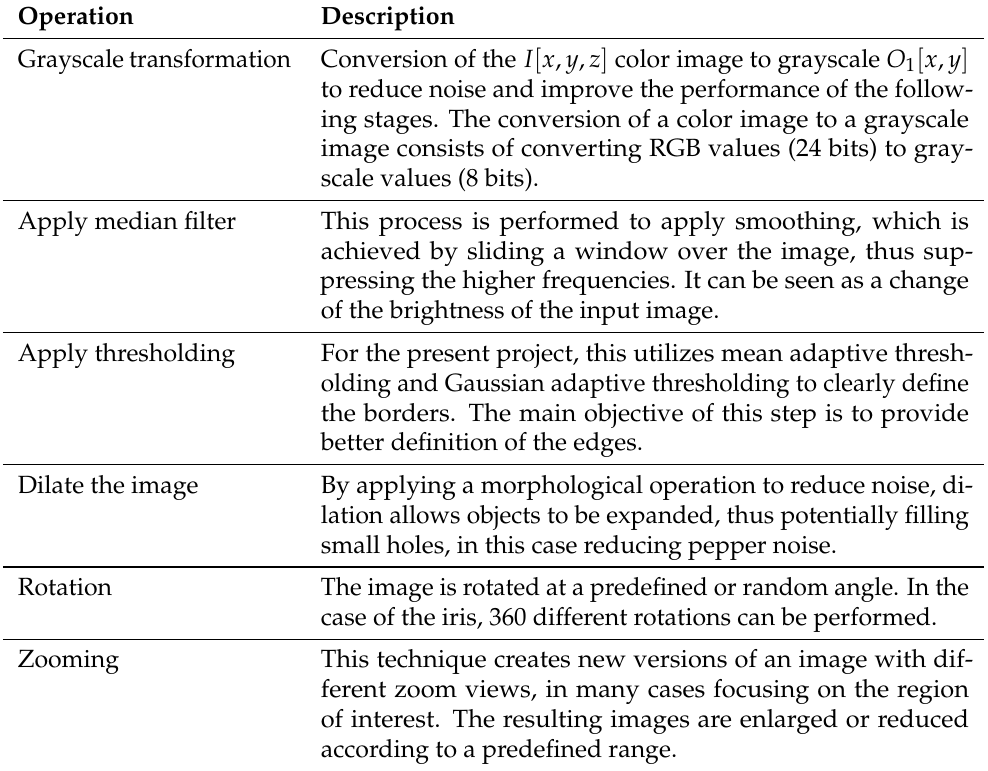
Figure 1. Specialist’s interface with different diagnostic options. Table 1. Operations that the specialist carries out on the images. These operations allow the doctor to perform a more reliable